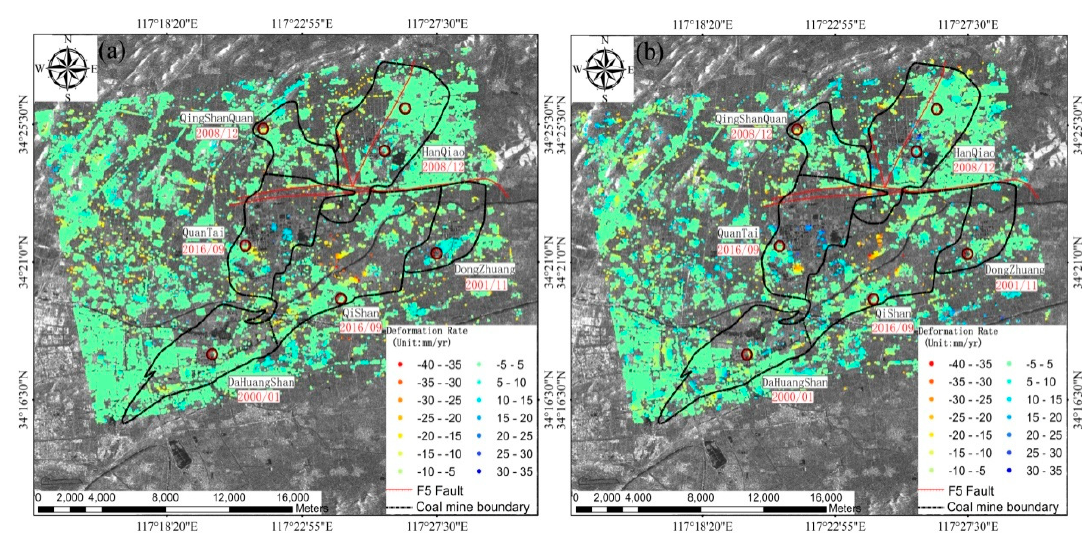
Figure 11. ( a ) The LOS annual average deformation rate from October 2016 to June 2017; and ( b ) the LOS annual average deformation rate from June 2017 to January 2018. The red-black circles show the locations of the main wells in the mining area, and the base map is the intensity image of ENVISAT obtained on March 16, 2010.